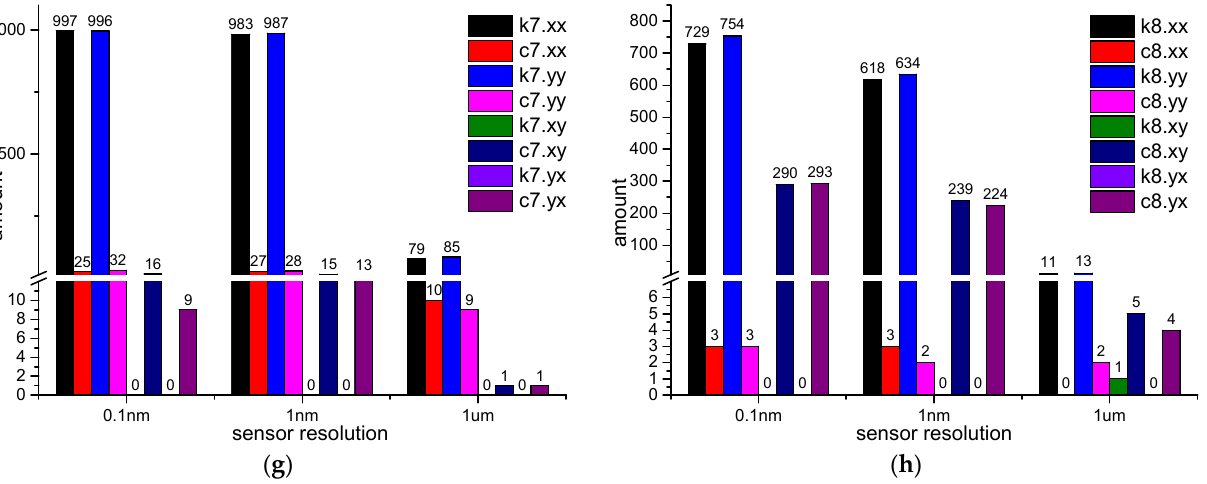
Figure 8. Statistical results of the amount of the frequencies, at which the related error is less than 10% or the absolute value is less than 10: ( a ) #1 bearing; ( b ) #2 bearing; ( c ) #3 bearing; ( d ) #4 bearing; ( e ) #5 bearing; ( f ) #6 bearing; ( g ) #7 bearing; ( h ) #8 bearing.